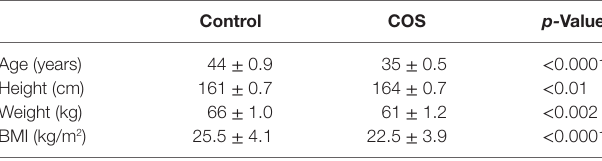
TaBle 2 | Demographic parameters of control and COS